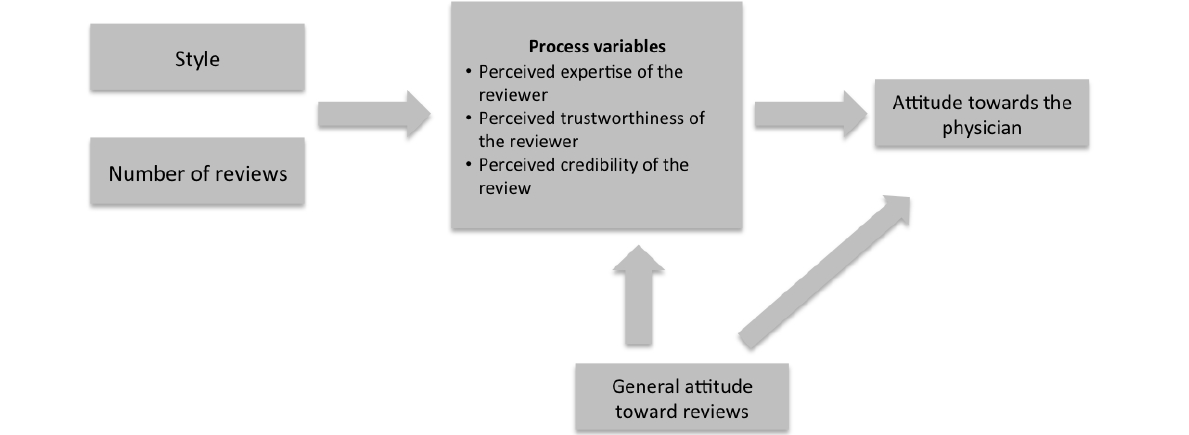
Figure 1. Influence of style and the number of reviews on attitude toward the reviewed